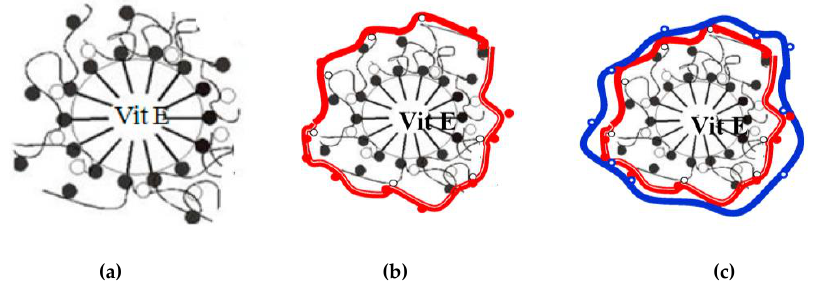
Figure 3. Schematic presentation of initial (PSS-DoTAB, ( a )), intermediate (PSS-DoTAB/Chitosan, ( b )) and final (PSS-DoTAB/Chitosan/PSS, ( c )) capsules with Vitamine E [24].